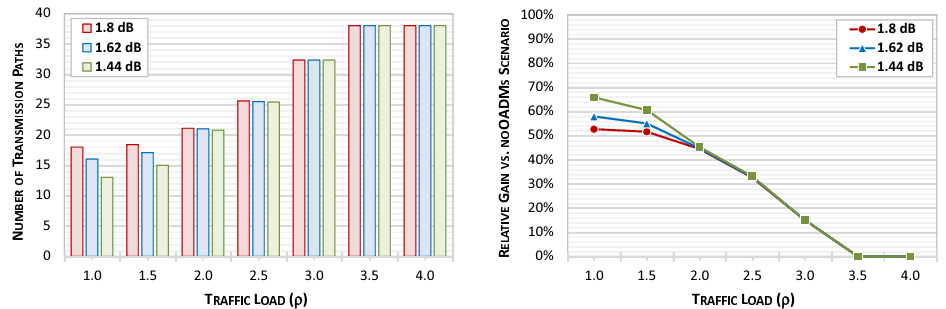
Figure 7. Number of transmission paths ( left ) and relative gain versus the network without OADMs ( right ) in a function of traffic load ( ρ ) for different MUX loss values in